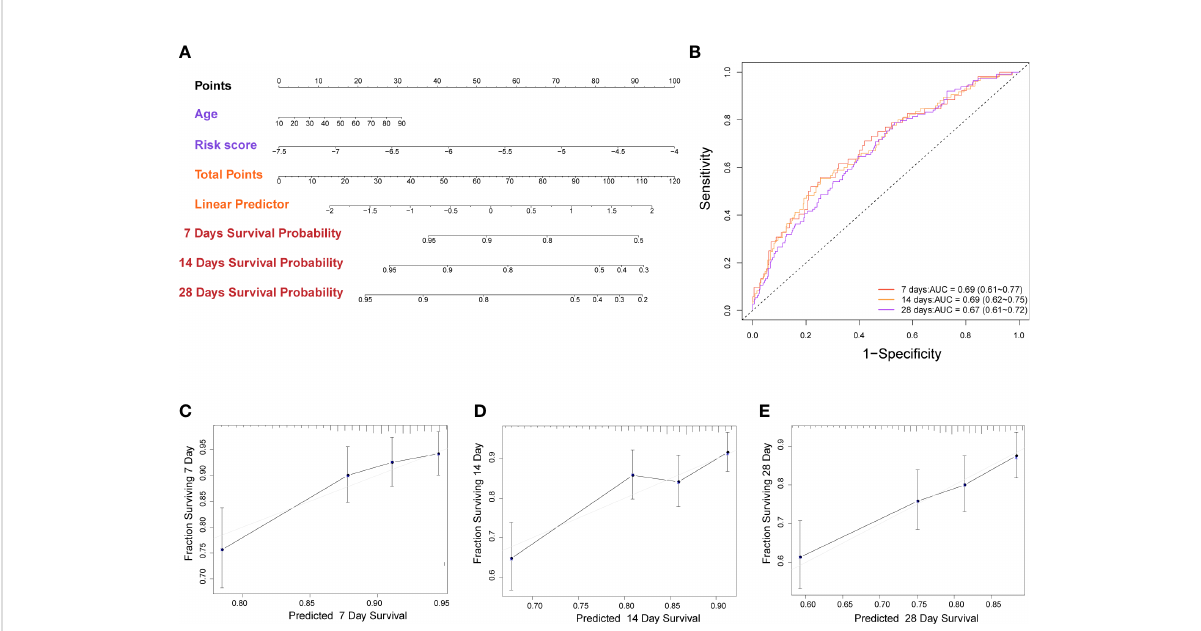
FIGURE 5 Construction of nomogram based on the pyroptosis-related prognostic risk score and clinical characteristic. (A) Nomogram for predicting 7-, 14-, and 28-day survival for sepsis patients. (B) Time-dependent receiver operating characteristic curves for 7-, 14-, and 28-day survival of patients. (C-E) Calibration curve of the nomogram for predicting 7-, 14-, and 28-day survival of patients.